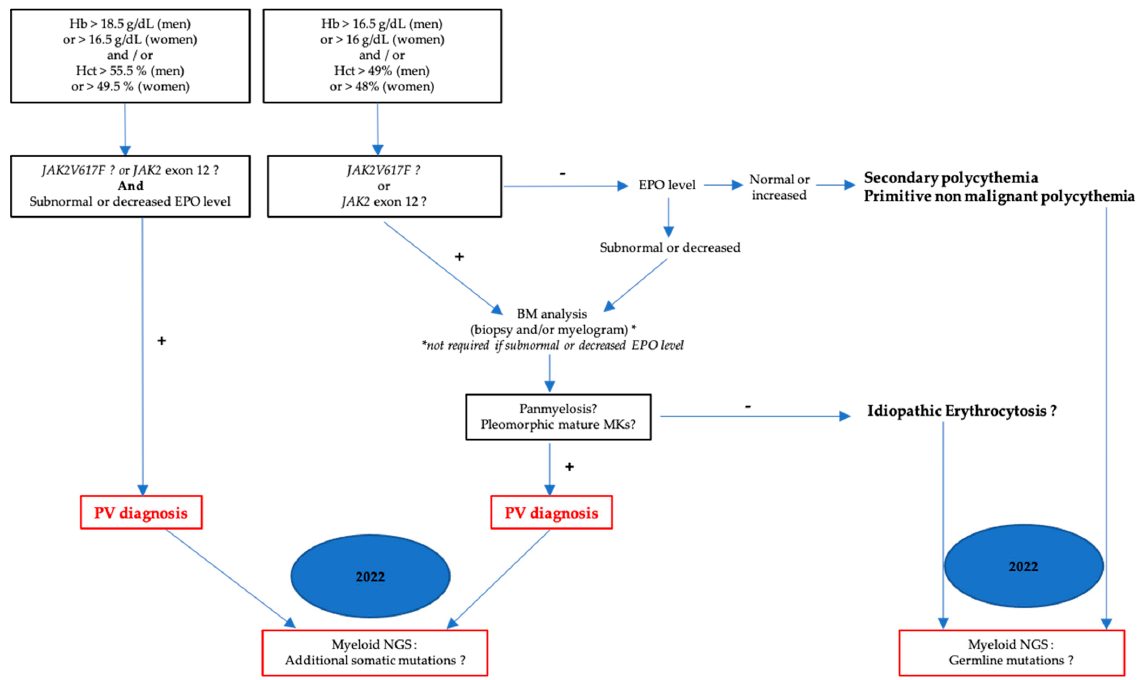
Figure 3. Diagnostic algorithm for PV.